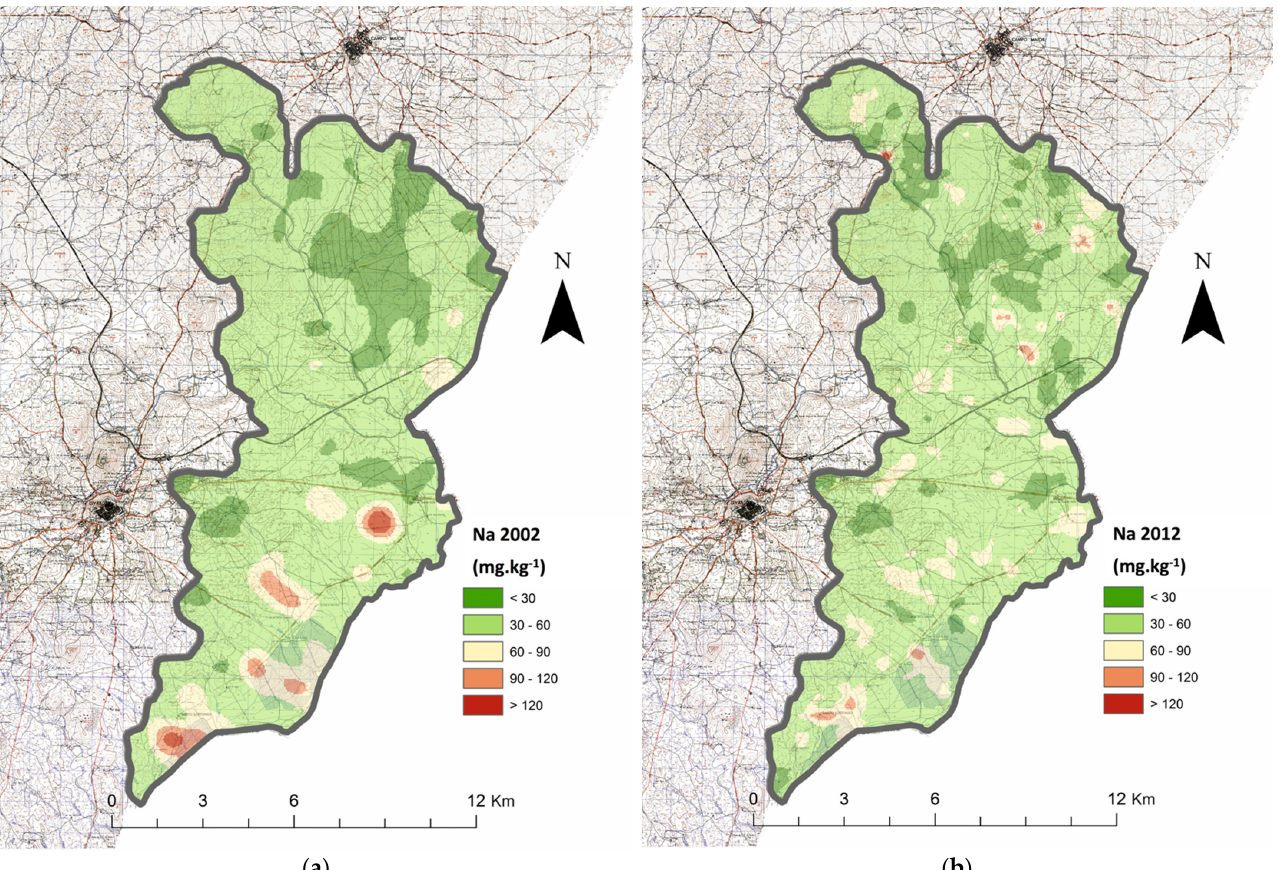
Figure 5. Available Na + content (mg.kg − 1 ) in the study area for ( a ) 2002 and ( b ) 2012.